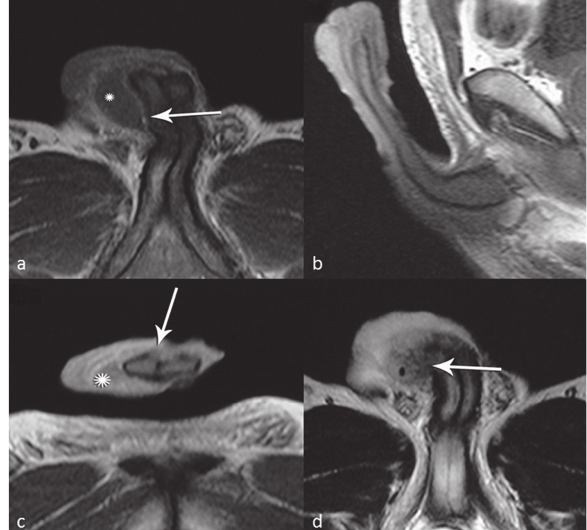
Figure-3 - A 40-year-old patient with penile fracture of the right corpus cavernosum. Unenhanced (a) and enhanced (b) T1-weighted images fail to reveal the tunical tear, whereas axial (c) coronal (d) T2-weighted images identify the tunical tear (arrows) with surrounding haematoma of the right corpus cavernosum in the proximal penile (asteriks).